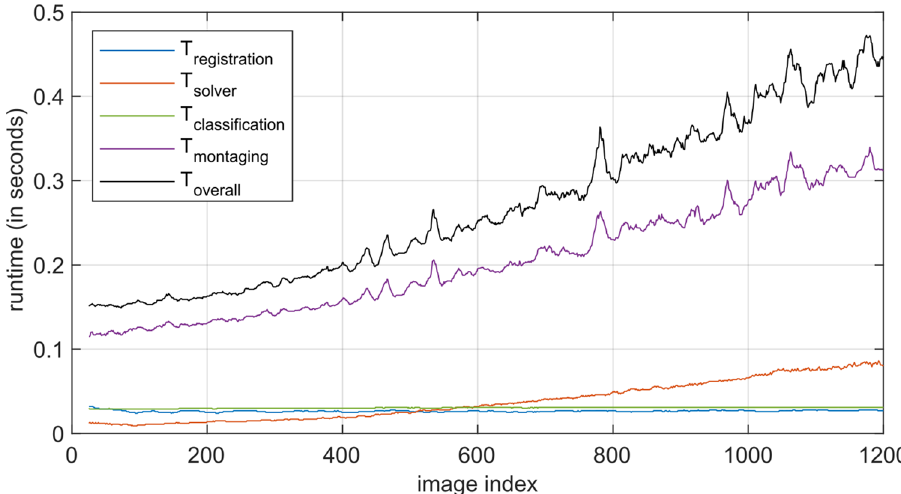
Figure 5. Processing time of the functional modules described in “Methods” with respect to the image index (median over datasets). The processing time of the image registration and tissue classification steps is independent of the image index. The processing time of the equation solver and mosaic montaging steps increases over the course of the imaging process.